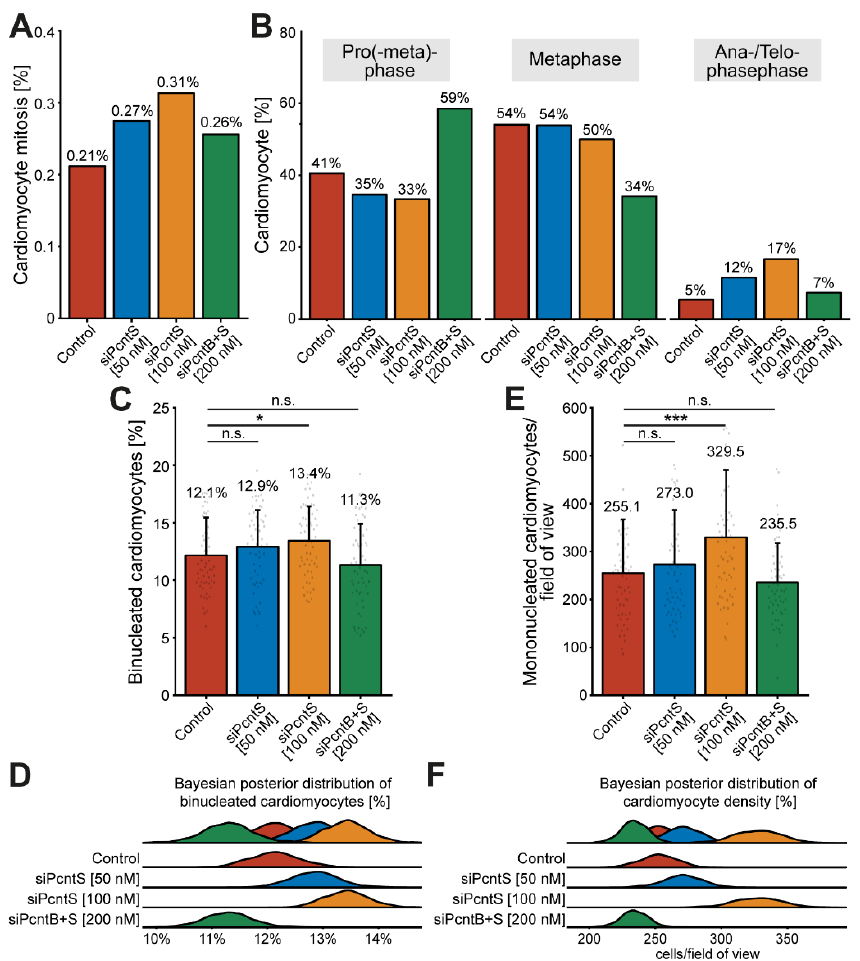
Figure 7. Pcnt S depletion enhances serum-induced cell division in cardiomyocytes. ( A ) Quantitative analysis of all mitotic cardiomyocyte within 3 independent experiments upon control and Pcnt isoform depletion as indicated. For the experiments, ≥ 18,000 cardiomyocytes were analyzed per experimental condition. An object classifier was utilized that identifies mitotic cells based on DNA staining patterns. ( B ) Classification of the observed mitotic cardiomyocytes into pro(-meta)phase, metaphase, and ana-/telophase. ( C , E ) Quantification of binucleation ( C ) and mononucleated cardiomyocyte density ( E ). For the experiments ≥ 16,023 cardiomyocytes were analyzed per experimental condition. Data are mean ± SD, n = 3, n.s.: p > 0.05, *: p < 0.05, ***: p < 0.001. ( D , F ) Bayesian posterior distribution for the data in ( C , E ).